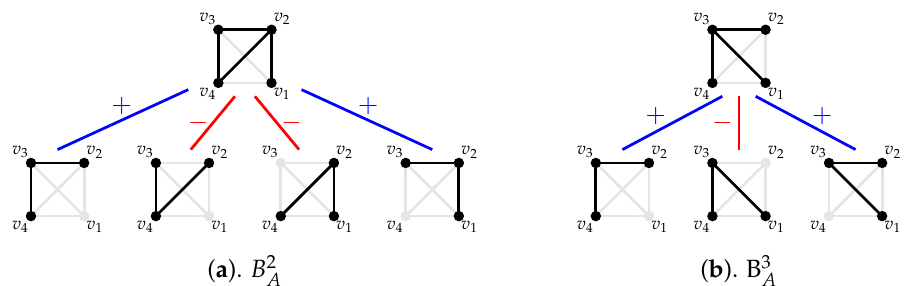
Figure 4. Basis subgraphs B 2 between